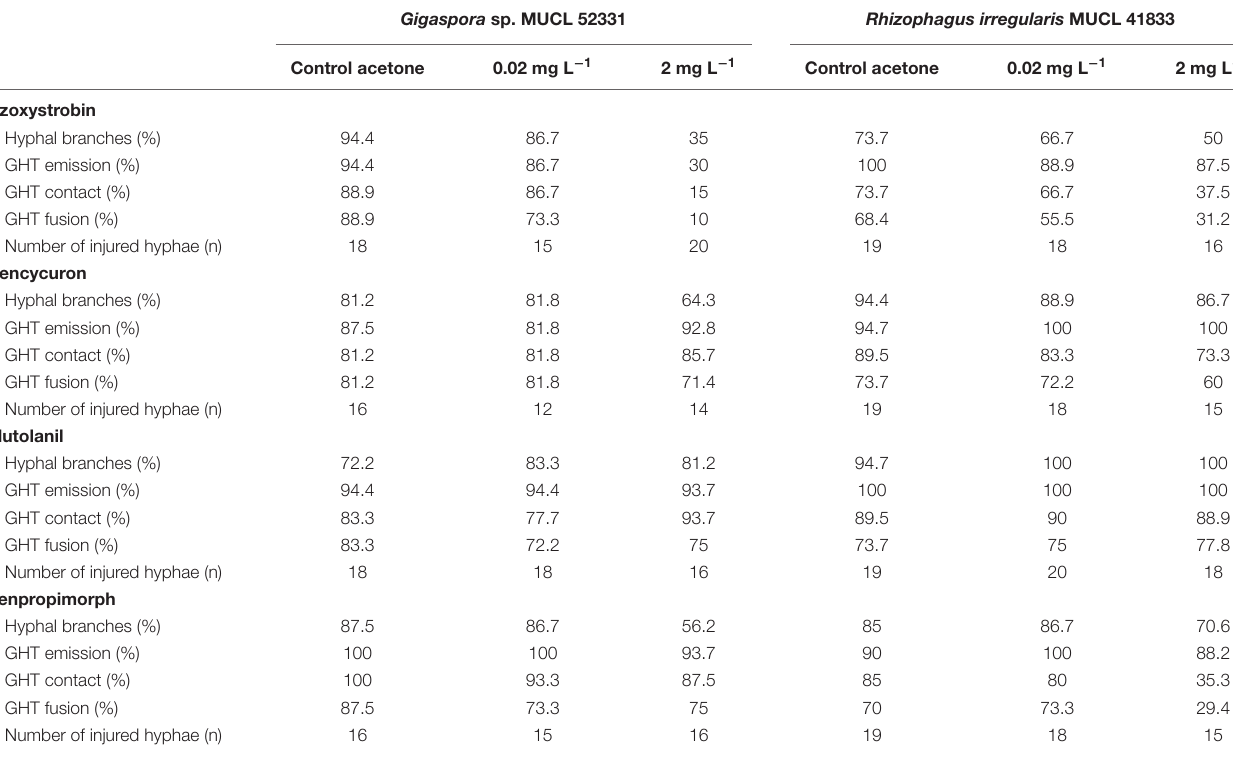
TABLE 1 | Descriptive data percentages of hyphal branches production, growing hyphal tips (GHTs) emission, contact and fusion of the hyphal healing mechanism (HHM) of Gigaspora sp. MUCL 52331 and Rhizophagus irregularis MUCL 41833 in absence (control acetone) or in presence of increasing concentrations